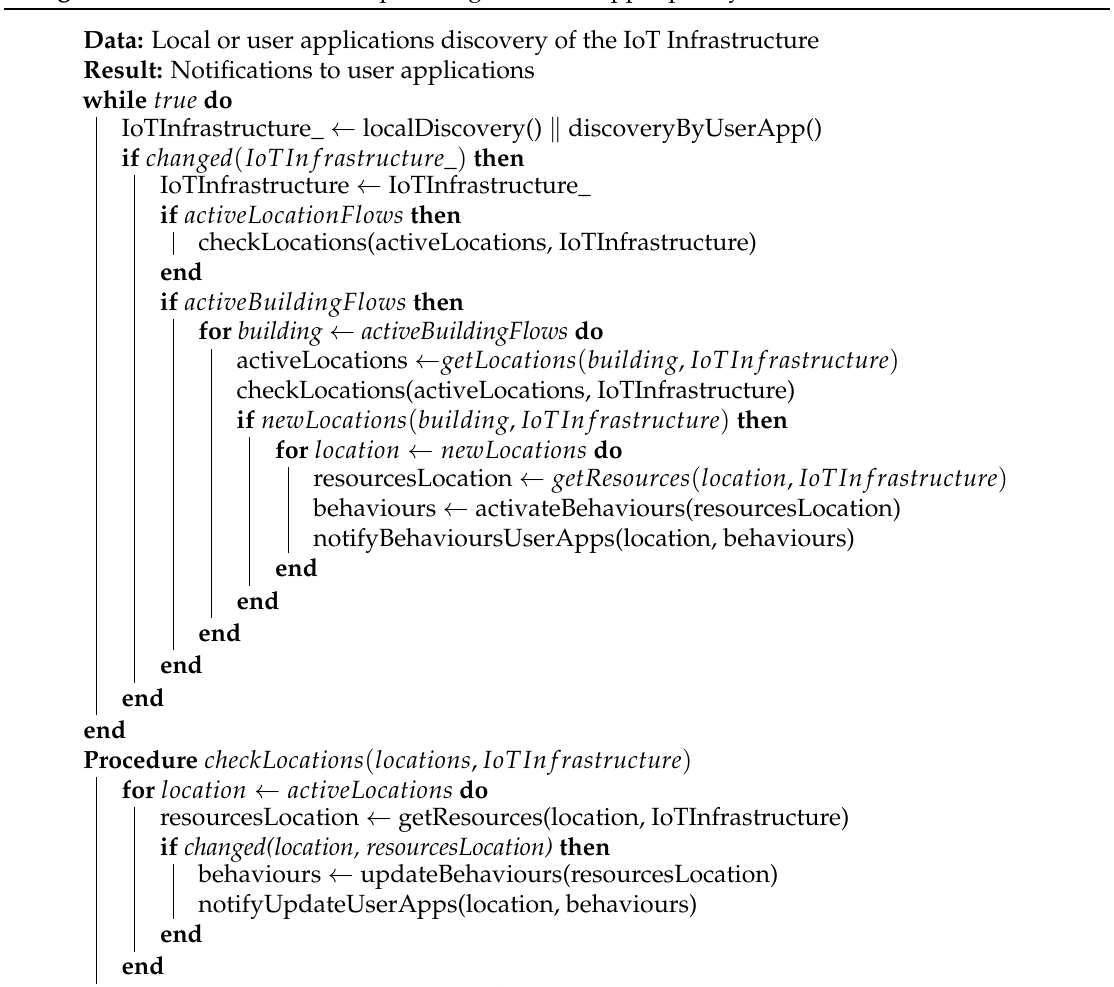
Algorithm 1: Overview of the update algorithm in